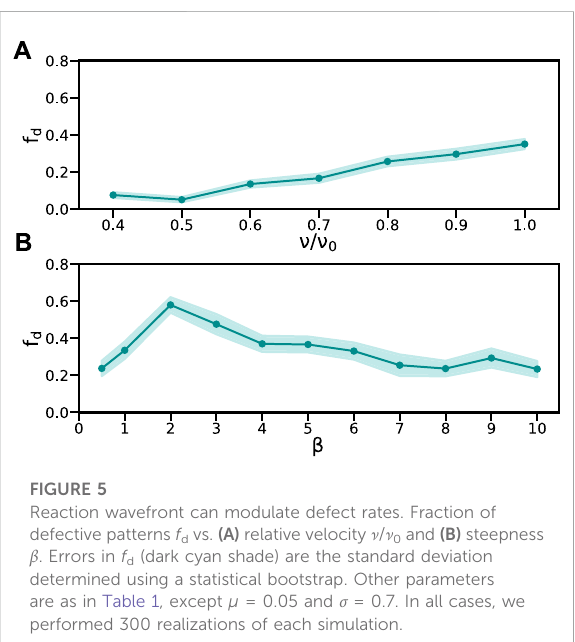
FIGURE 5 Reaction wavefront can modulate defect rates. Fraction of defective patterns f d vs. (A) relative velocity ] / ] 0 and (B) steepness β . Errors in f d (dark cyan shade) are the standard deviation determined using a statistical bootstrap. Other parameters are as in Table 1, except μ = 0.05 and σ = 0.7. In all cases, we performed 300 realizations of each